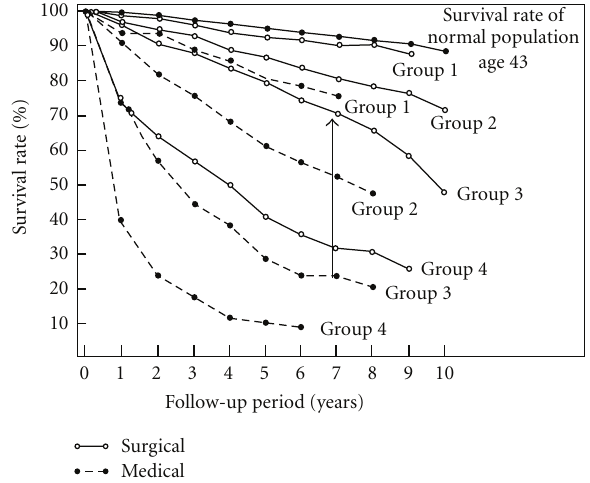
Figure 2: Survival rates in patients with malignant hypertension at various stages (Group 1–4) treated either medically or surgically (modified from Smithwick and Thompson [39]). Figure 3: Survival rates in untreated and medically treated patients with malignanthypertension (modified from Harington et al. [40]).